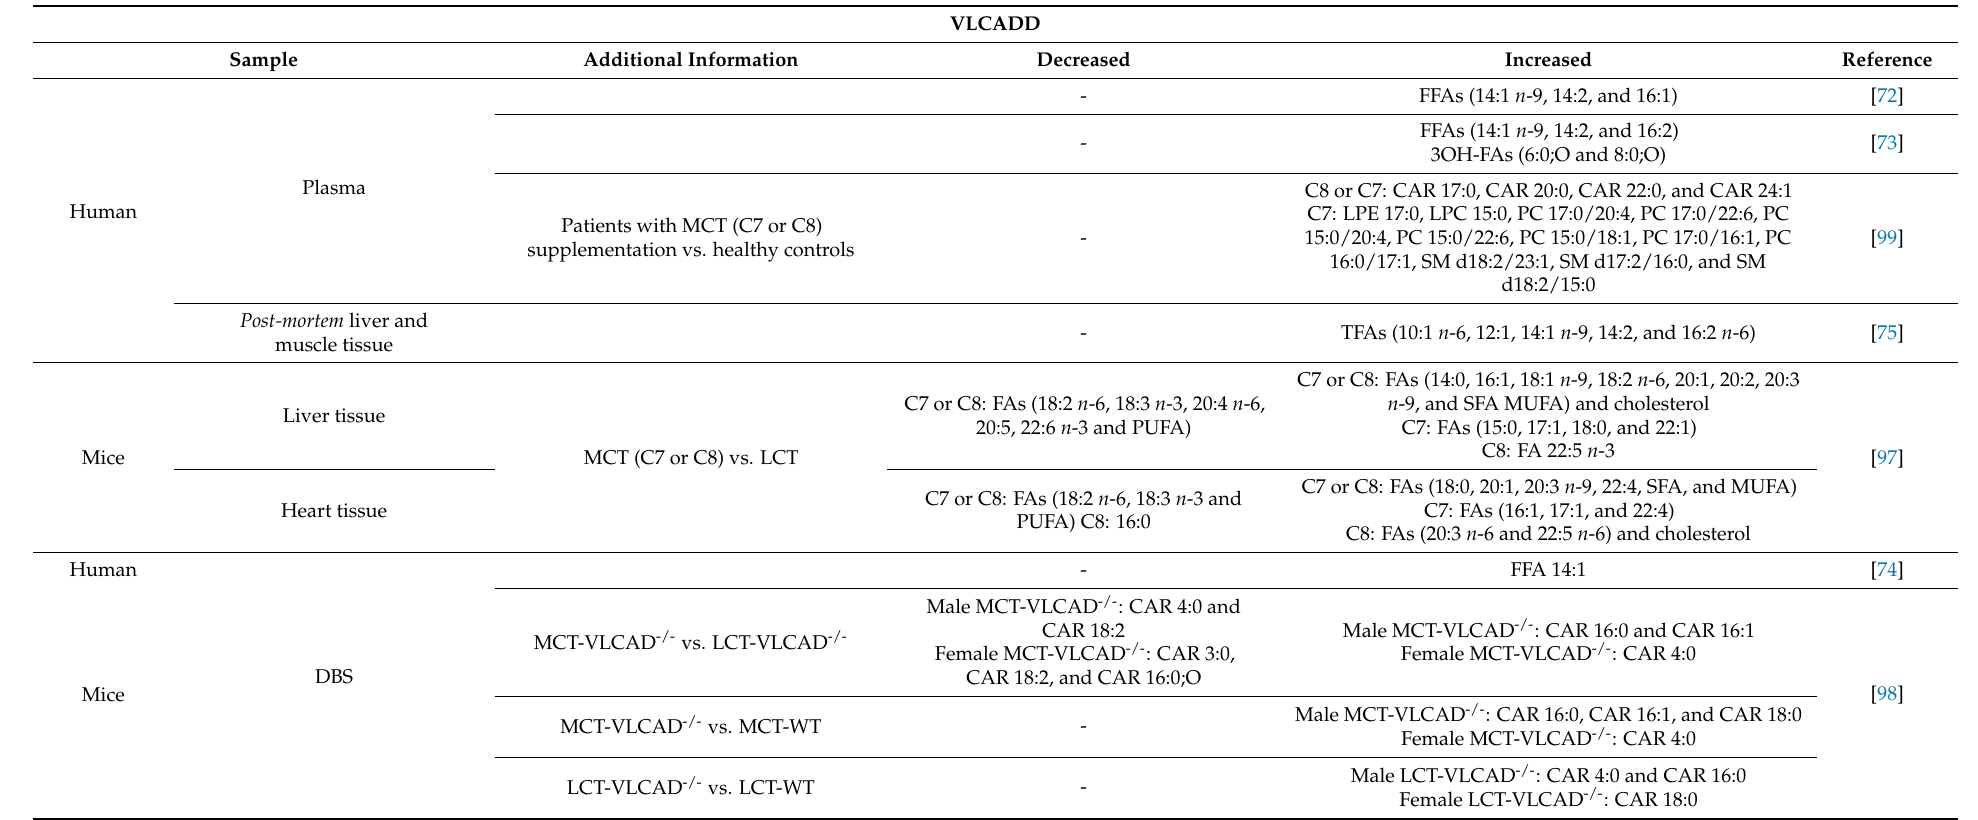
Table 4. Main changes in the lipid profile in the plasma, dried blood spots (DBSs), and skin fibroblasts of very long chain acyl-CoA dehydrogenase deficiency (VLCADD) patients and mice reported in published